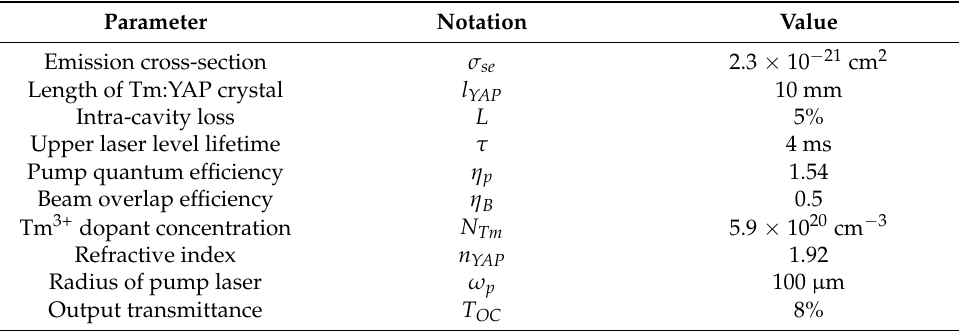
Table 1. Partial parameter of numerical modeling [40–44].